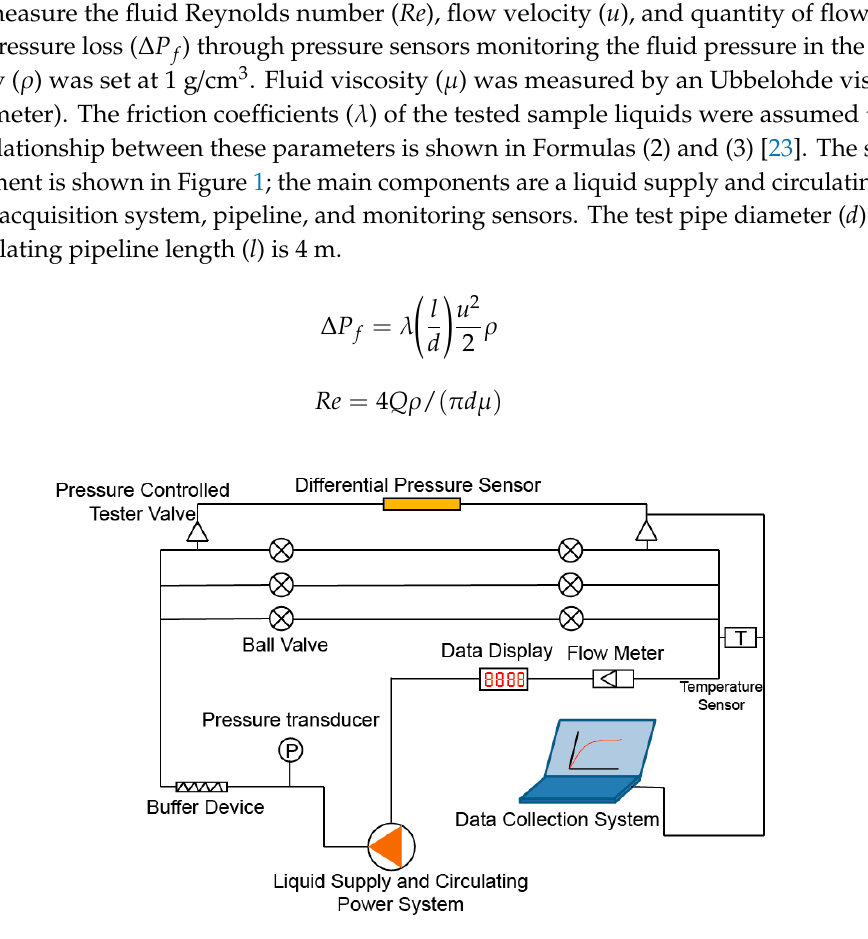
Figure 1. Structural schematic diagram of the MZ-II friction instrument for the drag reduction (DR) test.